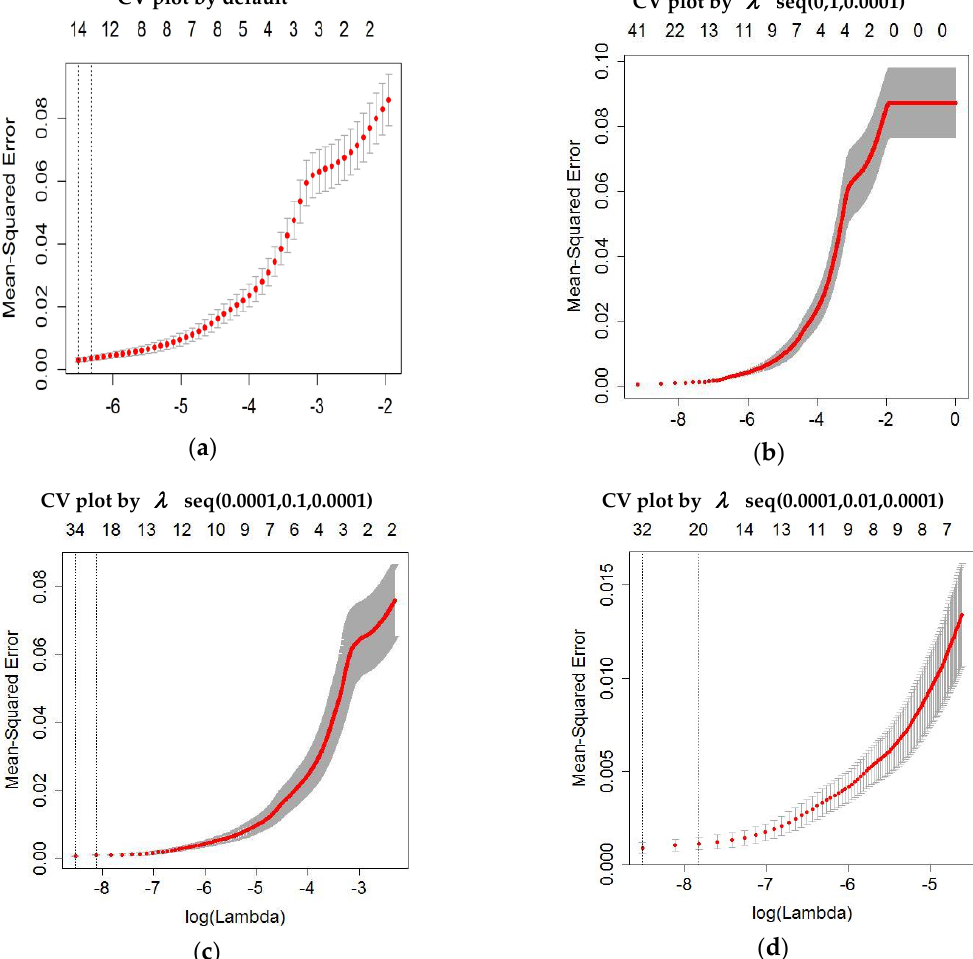
Figure 3. Cross-validation (CV) plot of mean squared error (MSE) corresponding to smoothing